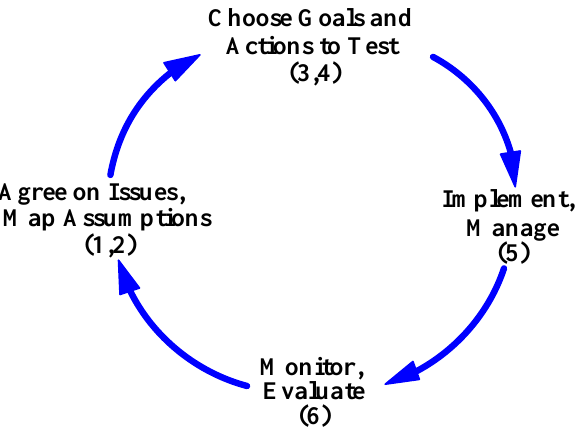
Figure 2: Adaptive Management Framework used in the Barycz Valley. Conceptual Modeling was incorporated into Assessment phase (steps 1 and